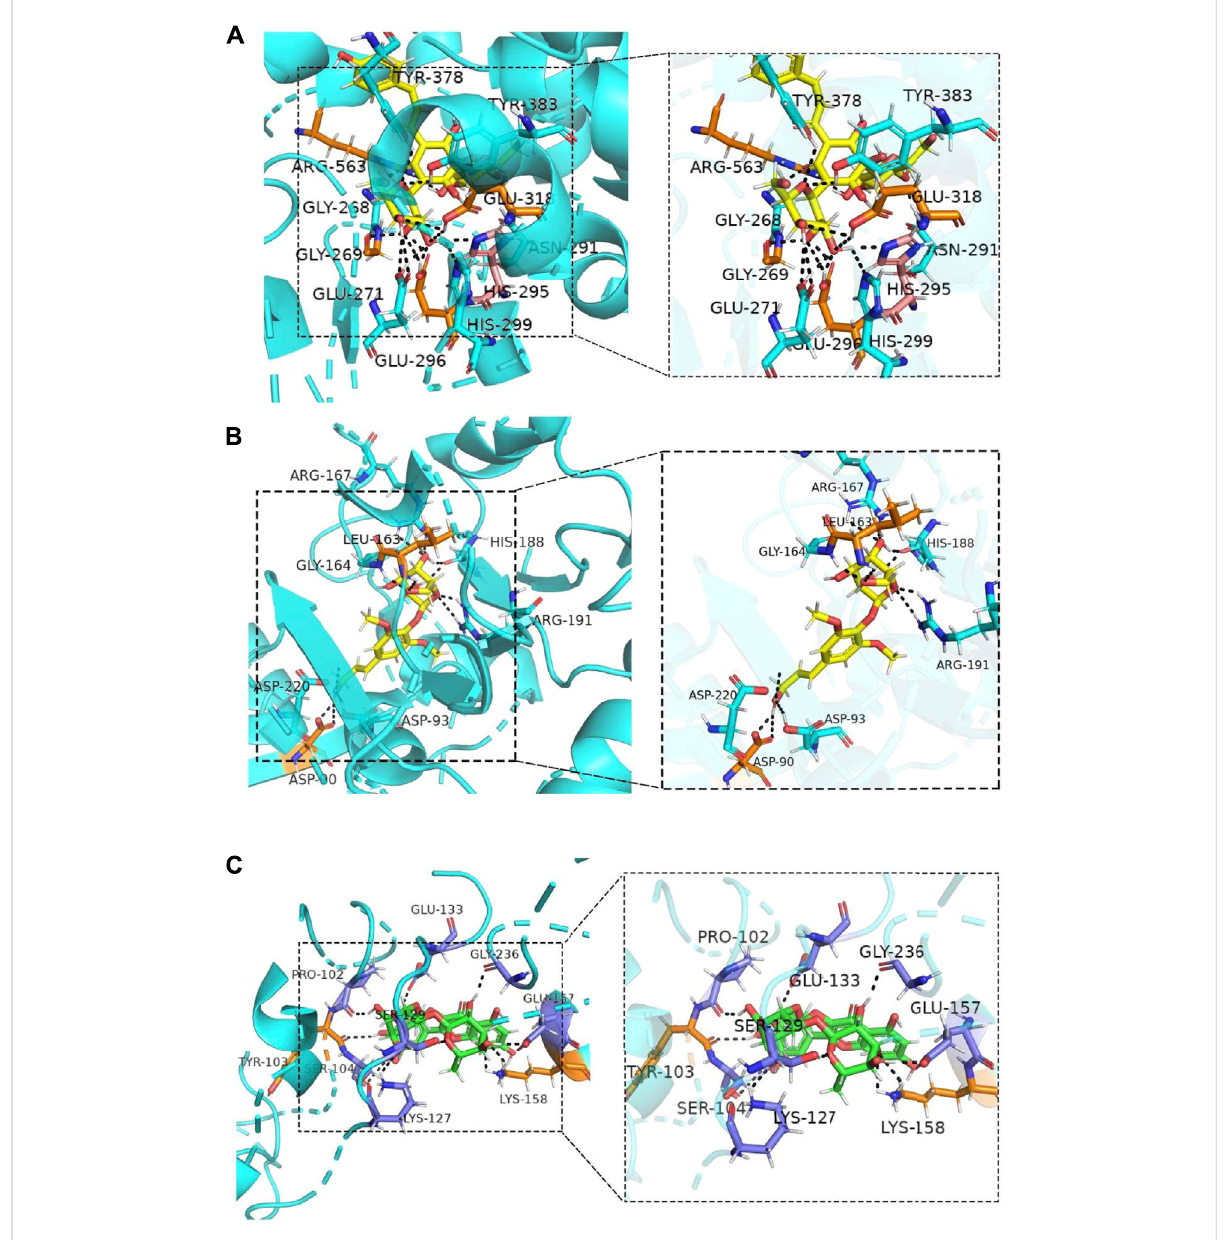
FIGURE 4 Molecular docking combinations of (A) HSYA, (B) SYR and (C) RU with their receptor targets, LTA-4H, SDH, and CTSB.